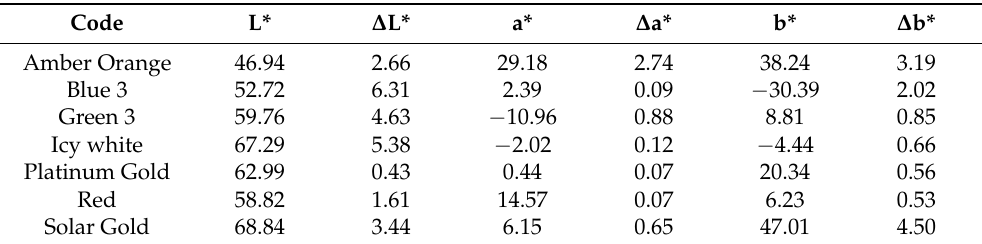
Table 5. Color measurements of inks on black Plike paper . The associated uncertainty of L*, a* and b*w is the standard deviation of the measurements.